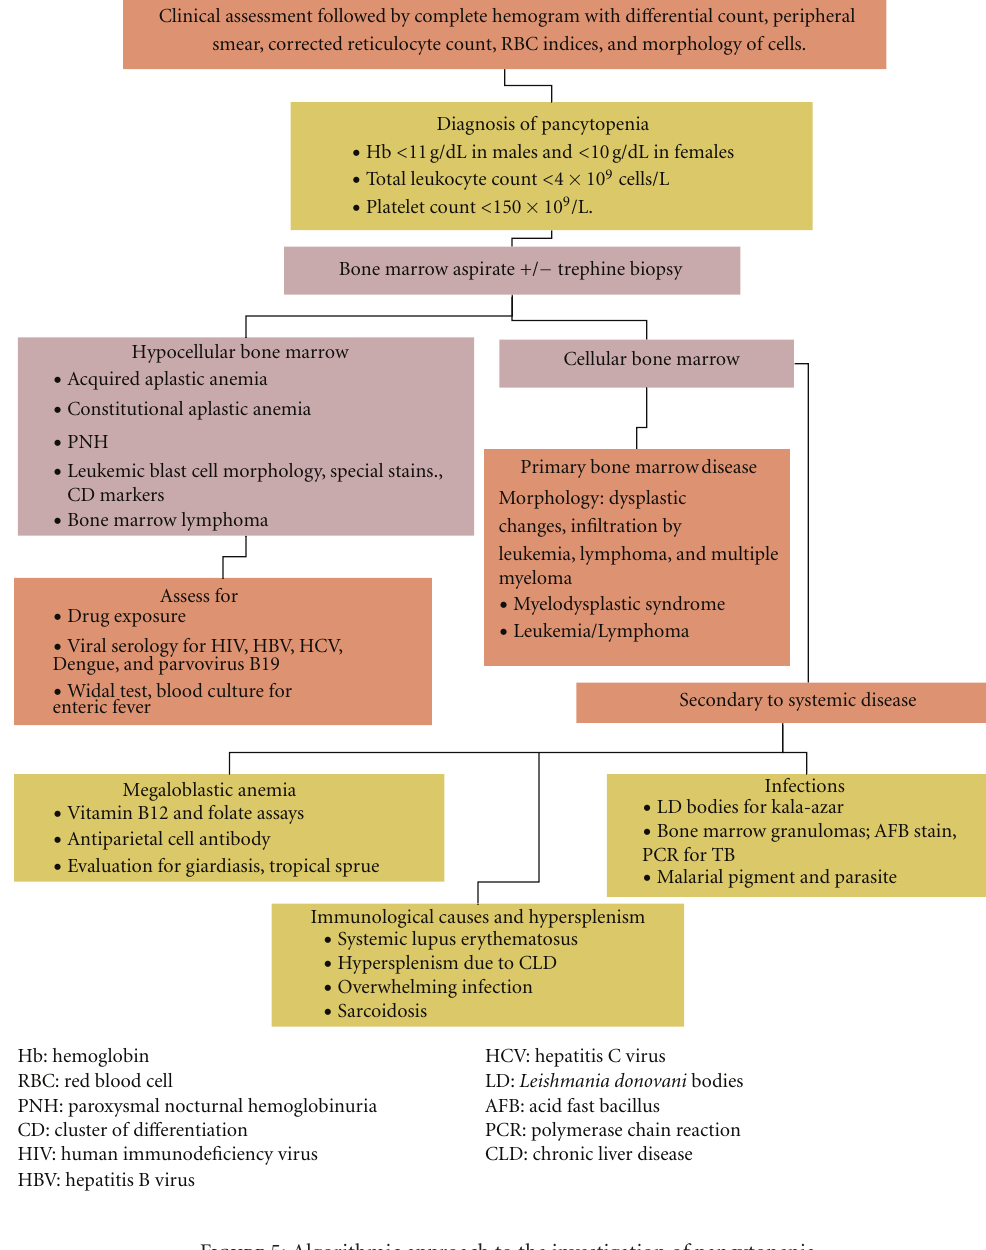
Figure 5: Algorithmic approach to the investigation of